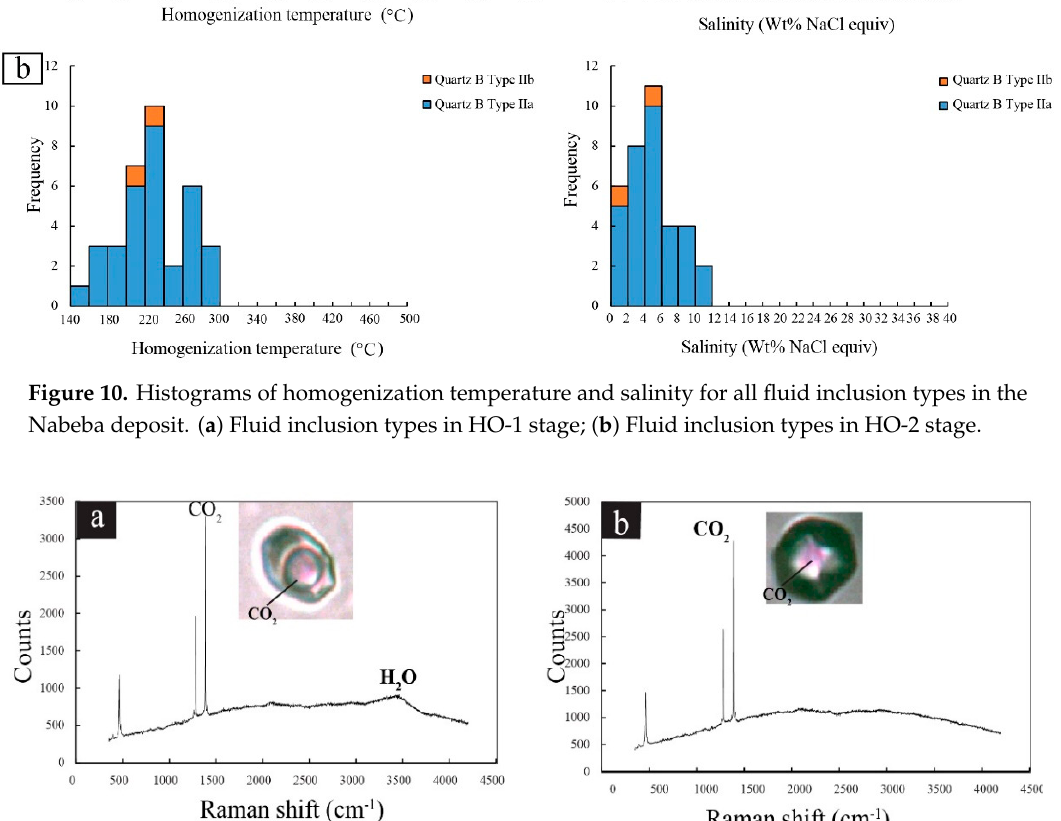
Table 2. Oxygen isotope data of vein quartz associated with hypogene iron ore in the Nabeba deposit. Sample Number